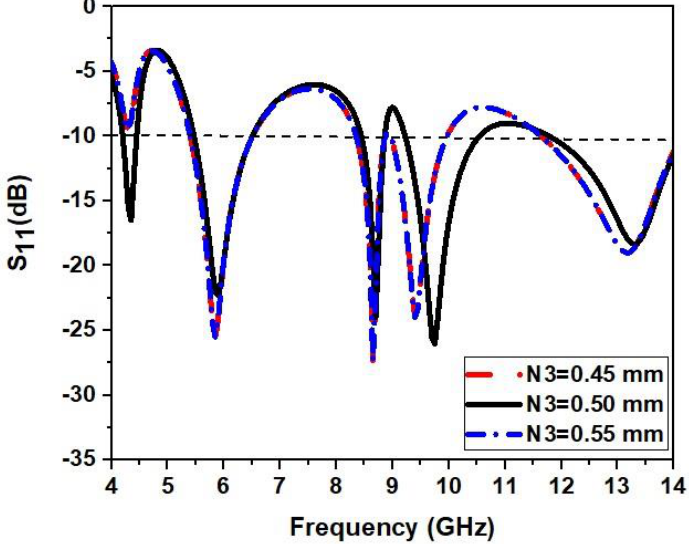
Figure 18. Parametric analysis for variation in N3 for S 11.